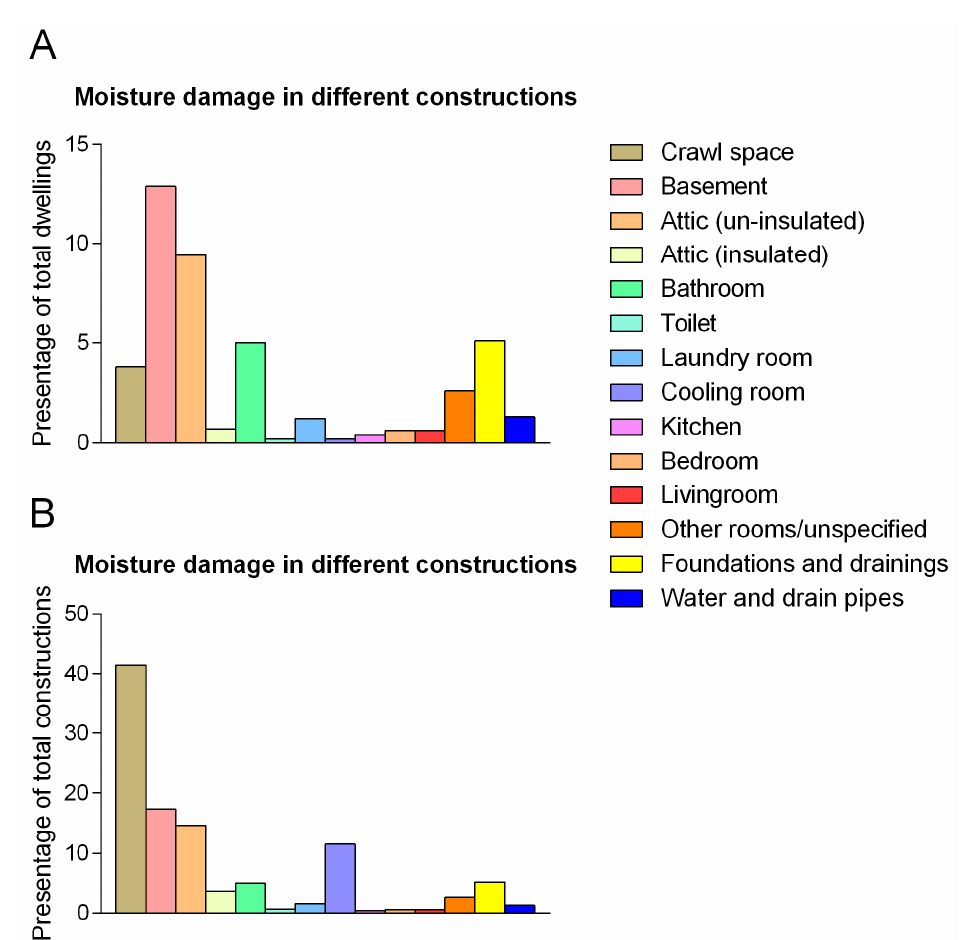
Figure 4. Moisture damage distributed by construction/room type. The figure display percentage of Norwegian dwellings with moisture damage in the different rooms ( A ) and the percent of the respective rooms with moisture damage ( B ). For instance, only a few inspected dwellings had crawl spaces or cooling rooms. Thus, while moisture damaged crawl spaces and cooling rooms were reported in less than 5% and 1% of all dwellings respectively, more than 40% of all crawl spaces and more than 10% of all cooling rooms were moisture damaged.